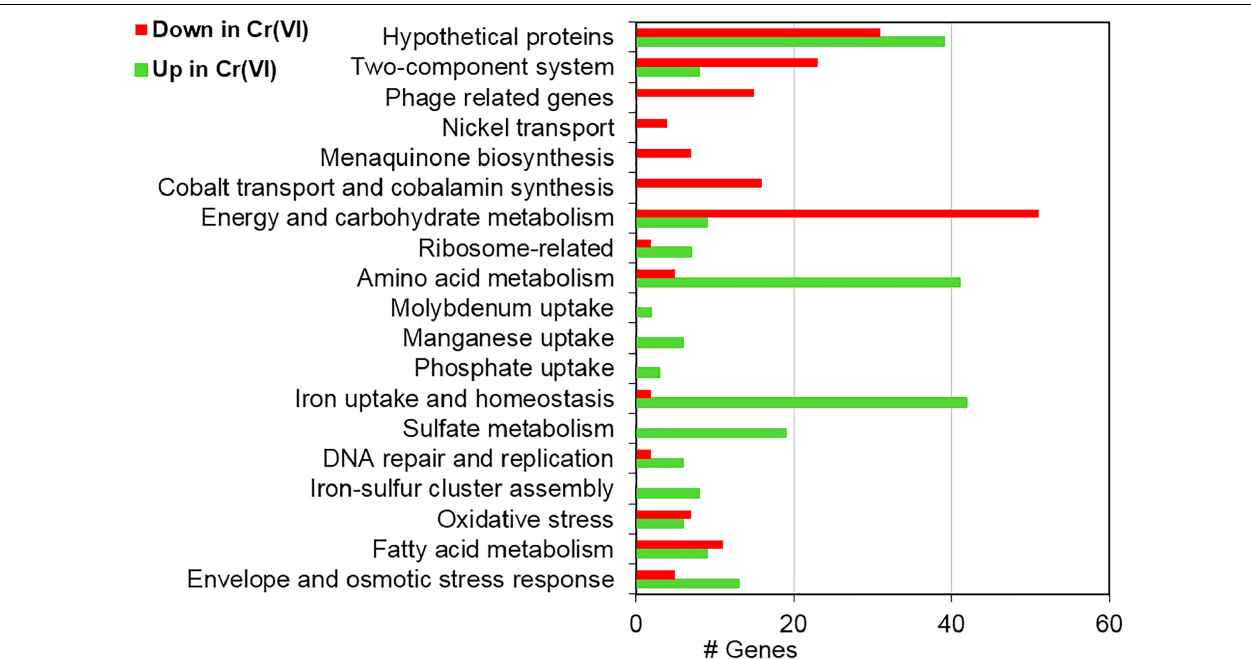
FIGURE 5 | Functional assignment of differentially transcribed genes of strain AqSCr grown in the presence of 11 mM Cr(VI) in LB medium (pH 8) with respect to controls.